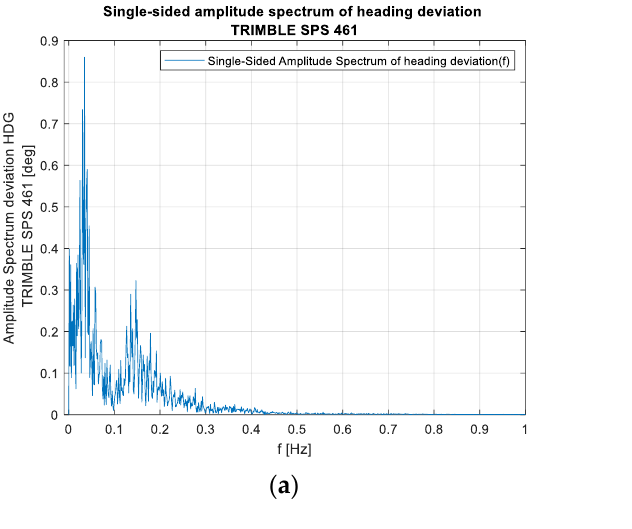
Figure 8. Typical recordings of the course made on the WildCat catamaran (frequency domain): ( a ) test #1, the vessel’s course is opposite to the wind direction, and ( b ) test #2, the vessel’s course follows the wind direction.